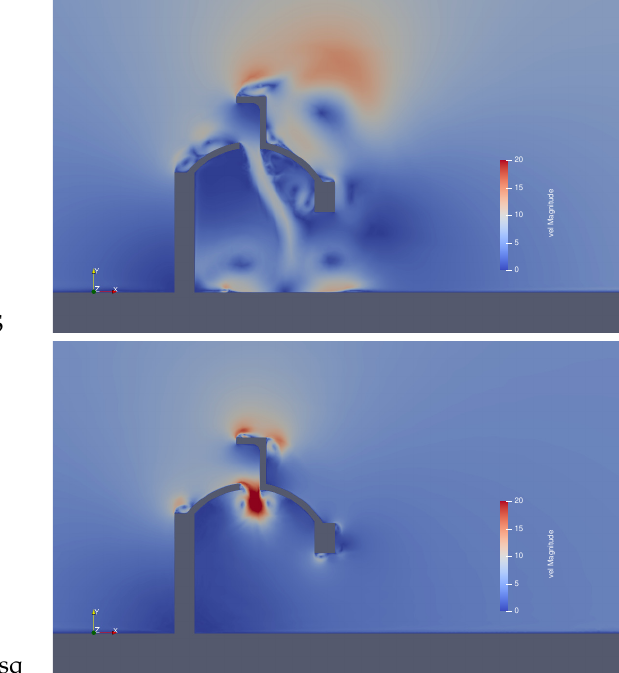
Figure 23. Wind tower 2. Velocity modulus obtained with the full NS and the Boussinesq model and U ∞ = 5 m/s.